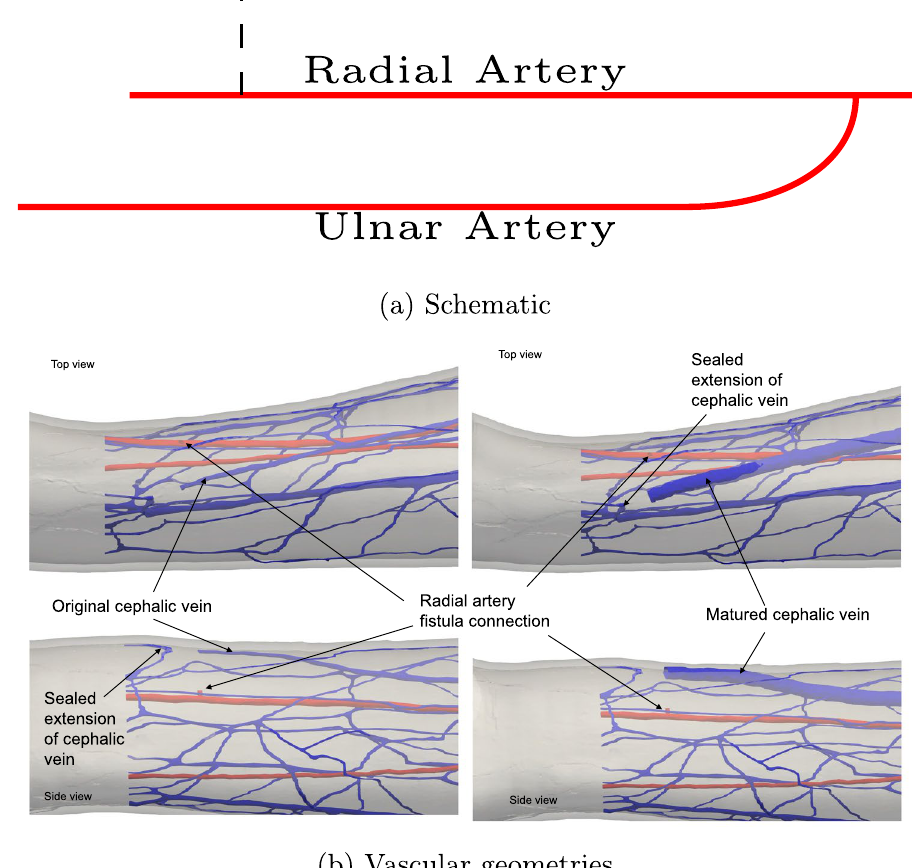
Figure 3. An arteriovenous fistula is created by artificially connecting sections of the arterial and venous vasculatures to alter the distribution of blood flow through the vessels. In ( a ) we provide a schematic map of the geometric modifications made to represent an end-to-side fistula. In this configuration, the cephalic vein is terminated early and attached to the radial artery. In ( b ) the realisation of these features in pre- and post- maturation geometries is highlighted. In the arterial domain, the bifurcation to the ulnar artery is approximately 150 mm upstream of the anastomosis while the outlet boundary is approximately 20 mm downstream. In the venous domain, the first junction of another vessel (diameter approximately 0.9 mm) with the cephalic vein is approximately 45 mm downstream from the inlet coming from the